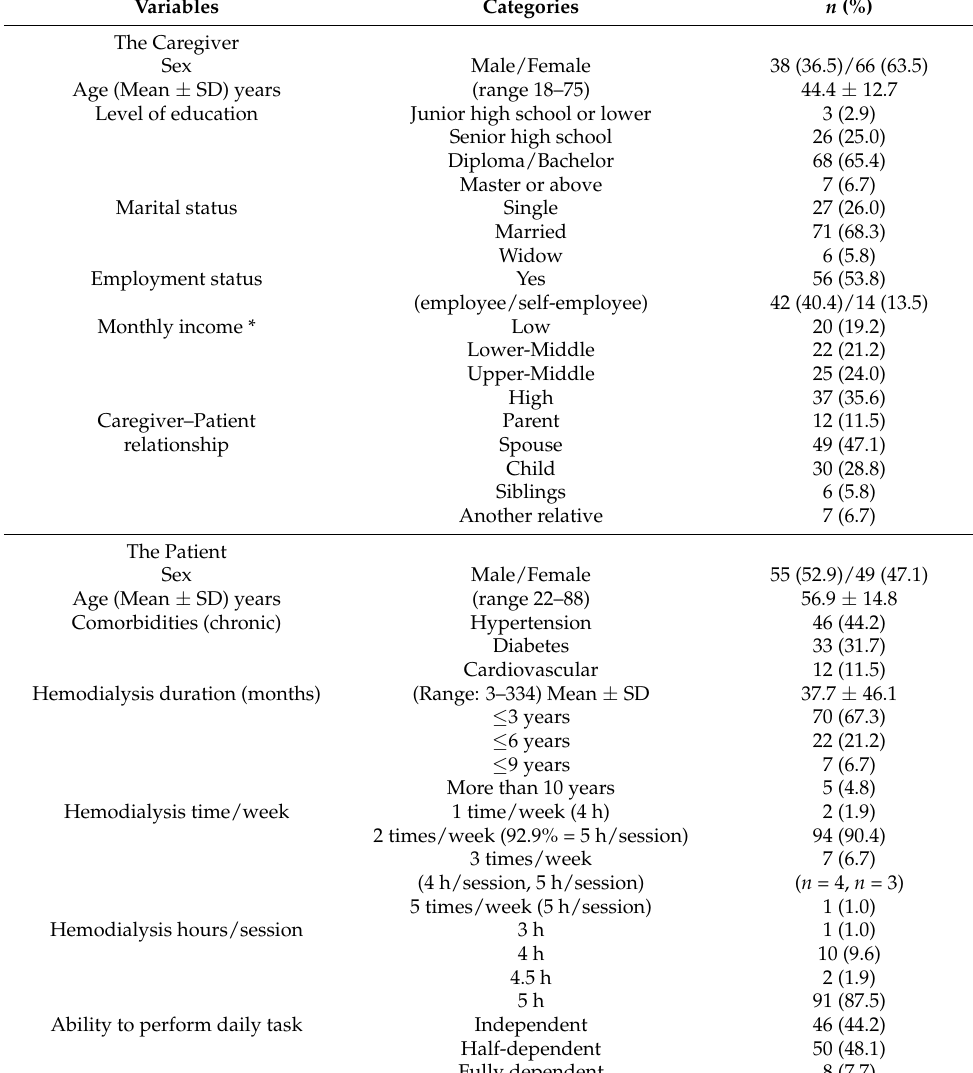
Table 1. Sociodemographic characteristics of patients and the